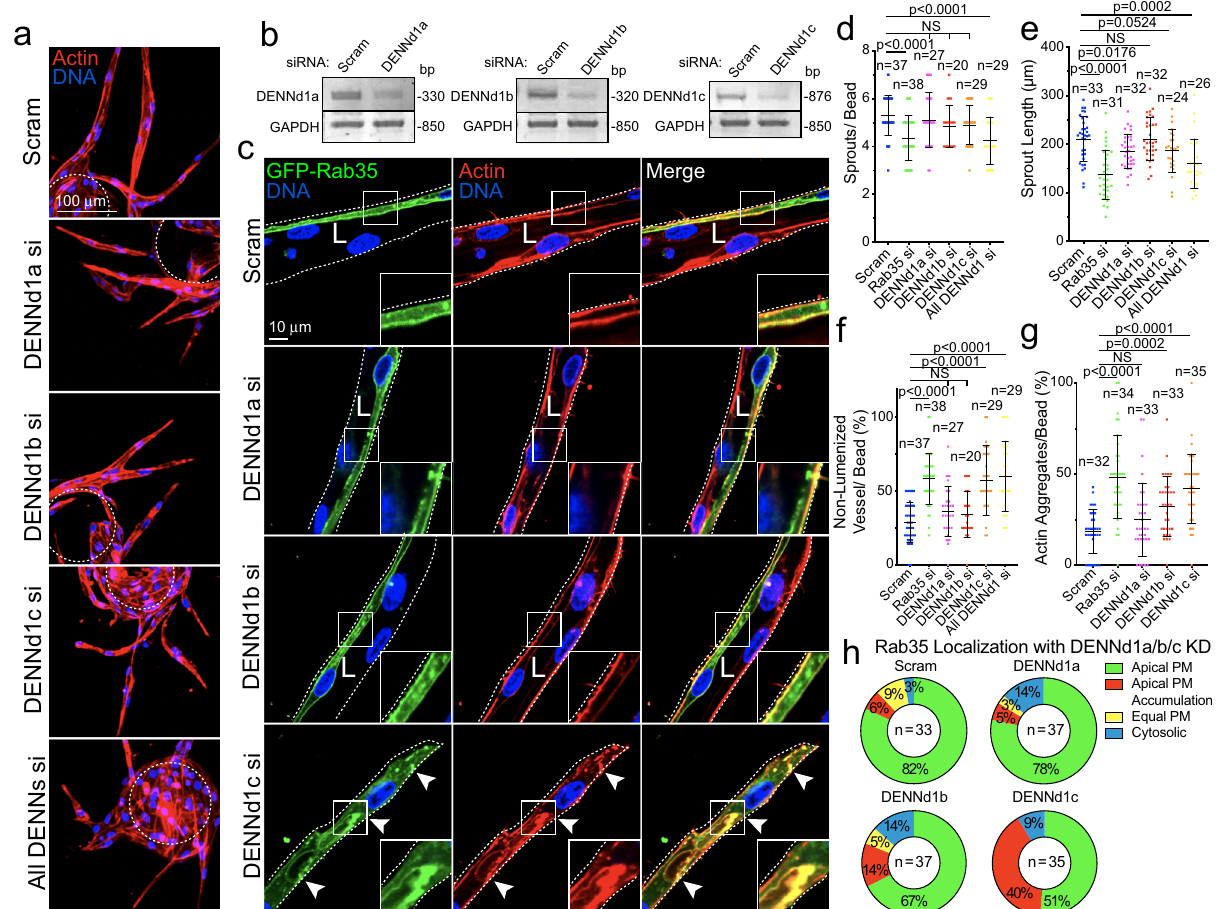
Fig. 5 | DENNd1c is required for sprouting and Rab35 function. a Sprout mor- phology of scramble (Scram), DENNd1a-c, and combined siRNA (si)-treated sprouts,stainedwithactintodenotethegeneralmorphology.Dashedlinedenotes microbead. b Knockdown con fi rmations for DENNd1a-c by RT-PCR. Base-pair (BP). c Representative images of siRNA knockdowns described in panel A with GFP- Rab35 localization. L denotes lumen and arrowheads denote abnormal actin accumulations. White dotted lines mark sprout exterior. d – g Graphs of indicated sprout parameters across groups. n =number of sprouts. Error bars represent